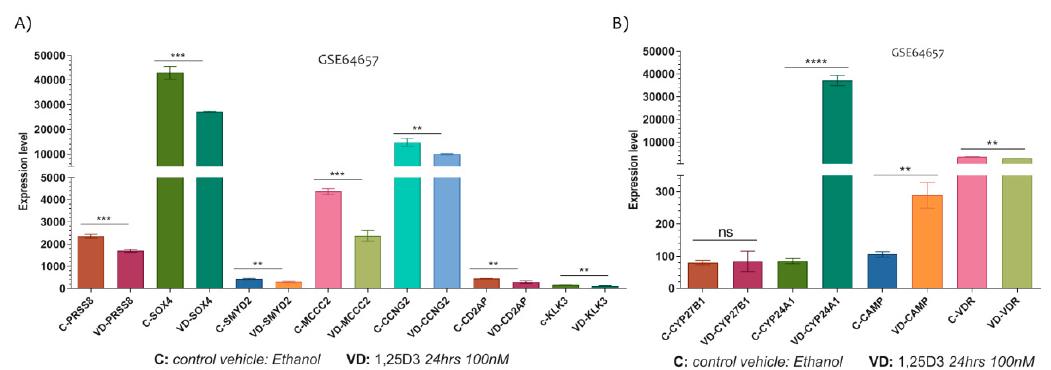
Figure 5. The Vitamin D-modulated PCa related genes. ( A ) The expression of PRSS8, SOX4, SMYD2, MCCC2, CCNG2 and CD2AP were significantly down-regulated in this LNCaP cell line at 24 h after exposition to 100 nM of 1,25D 3 . ( B ) In addiction, the expression levels of Vitamin D metabolism genes were significantly modulated in LNCaP cells line under 1,25D 3 exposition (no significant modulation was observed for CYP27B1) (Data are expressed as expression levels and presented as vertical bars. p values < 0.05 were considered to be statistically significant ** p < 0.005; *** p < 0.0005; **** p < 0.00005).